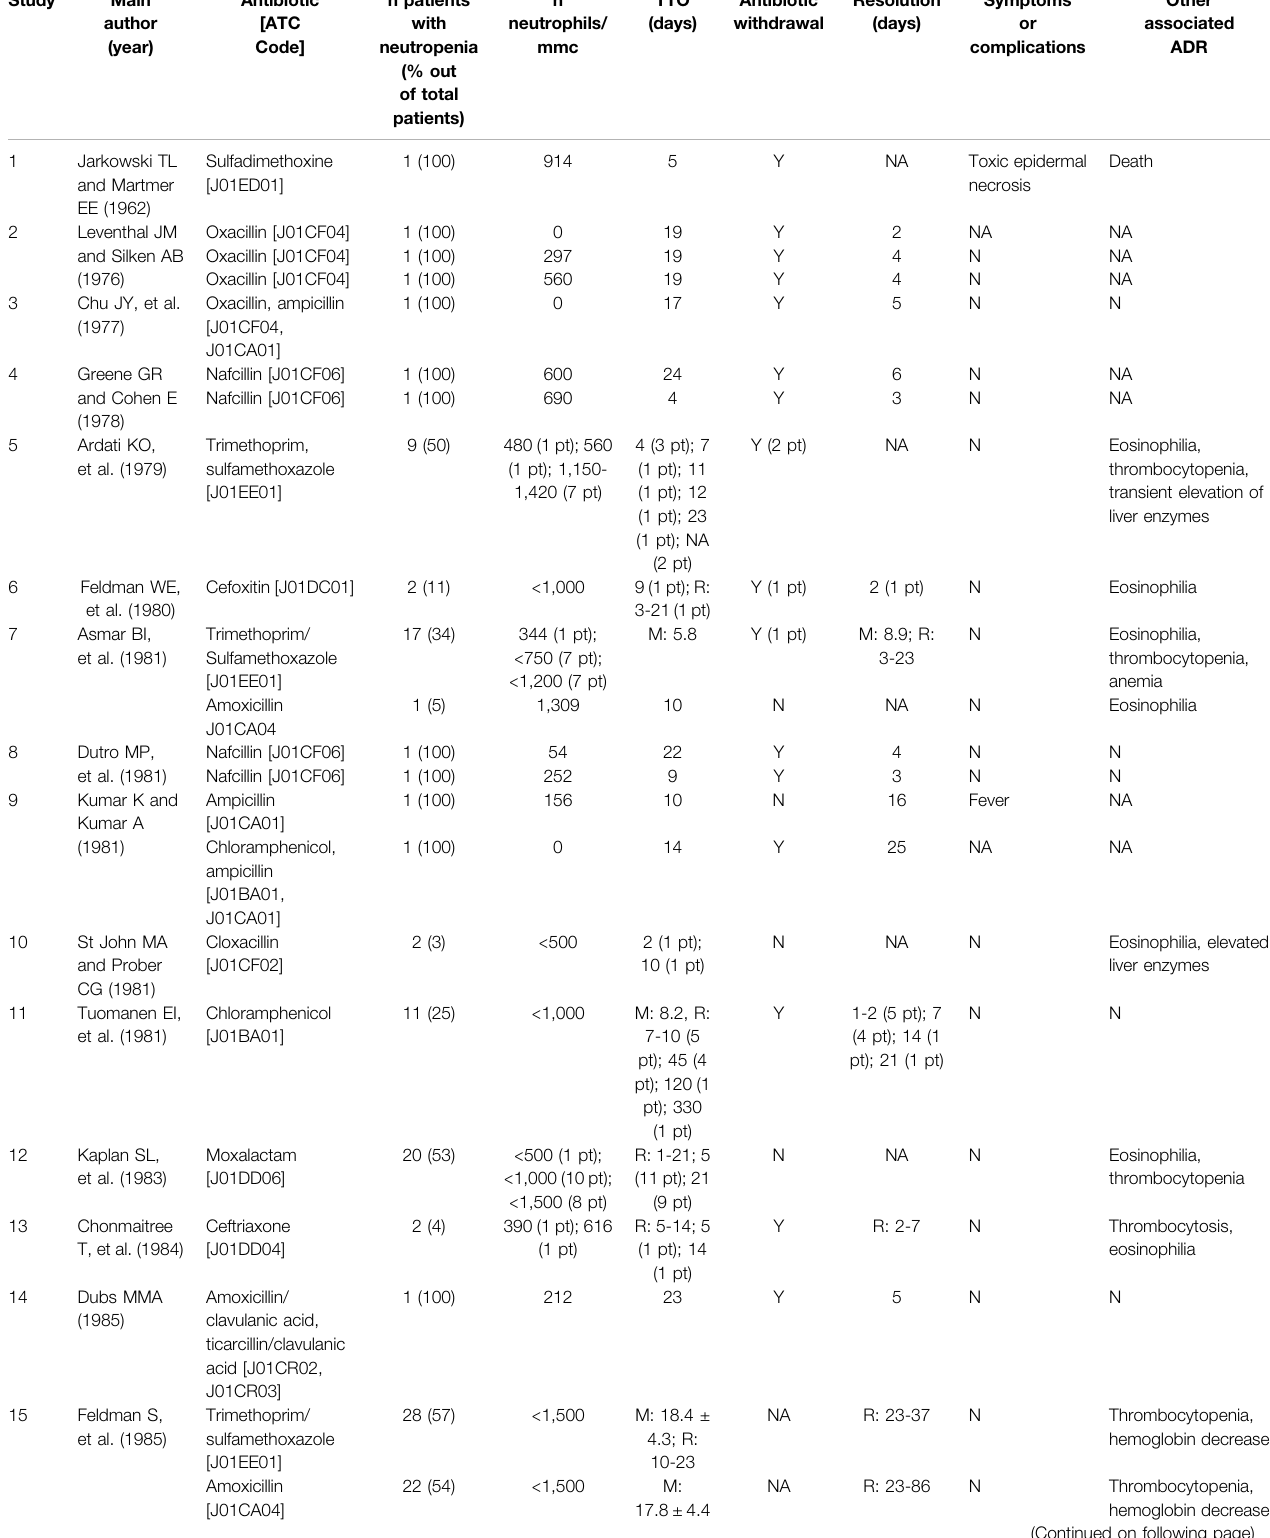
TABLE 2 | Details of neutropenia occurrence in studies included in TTO